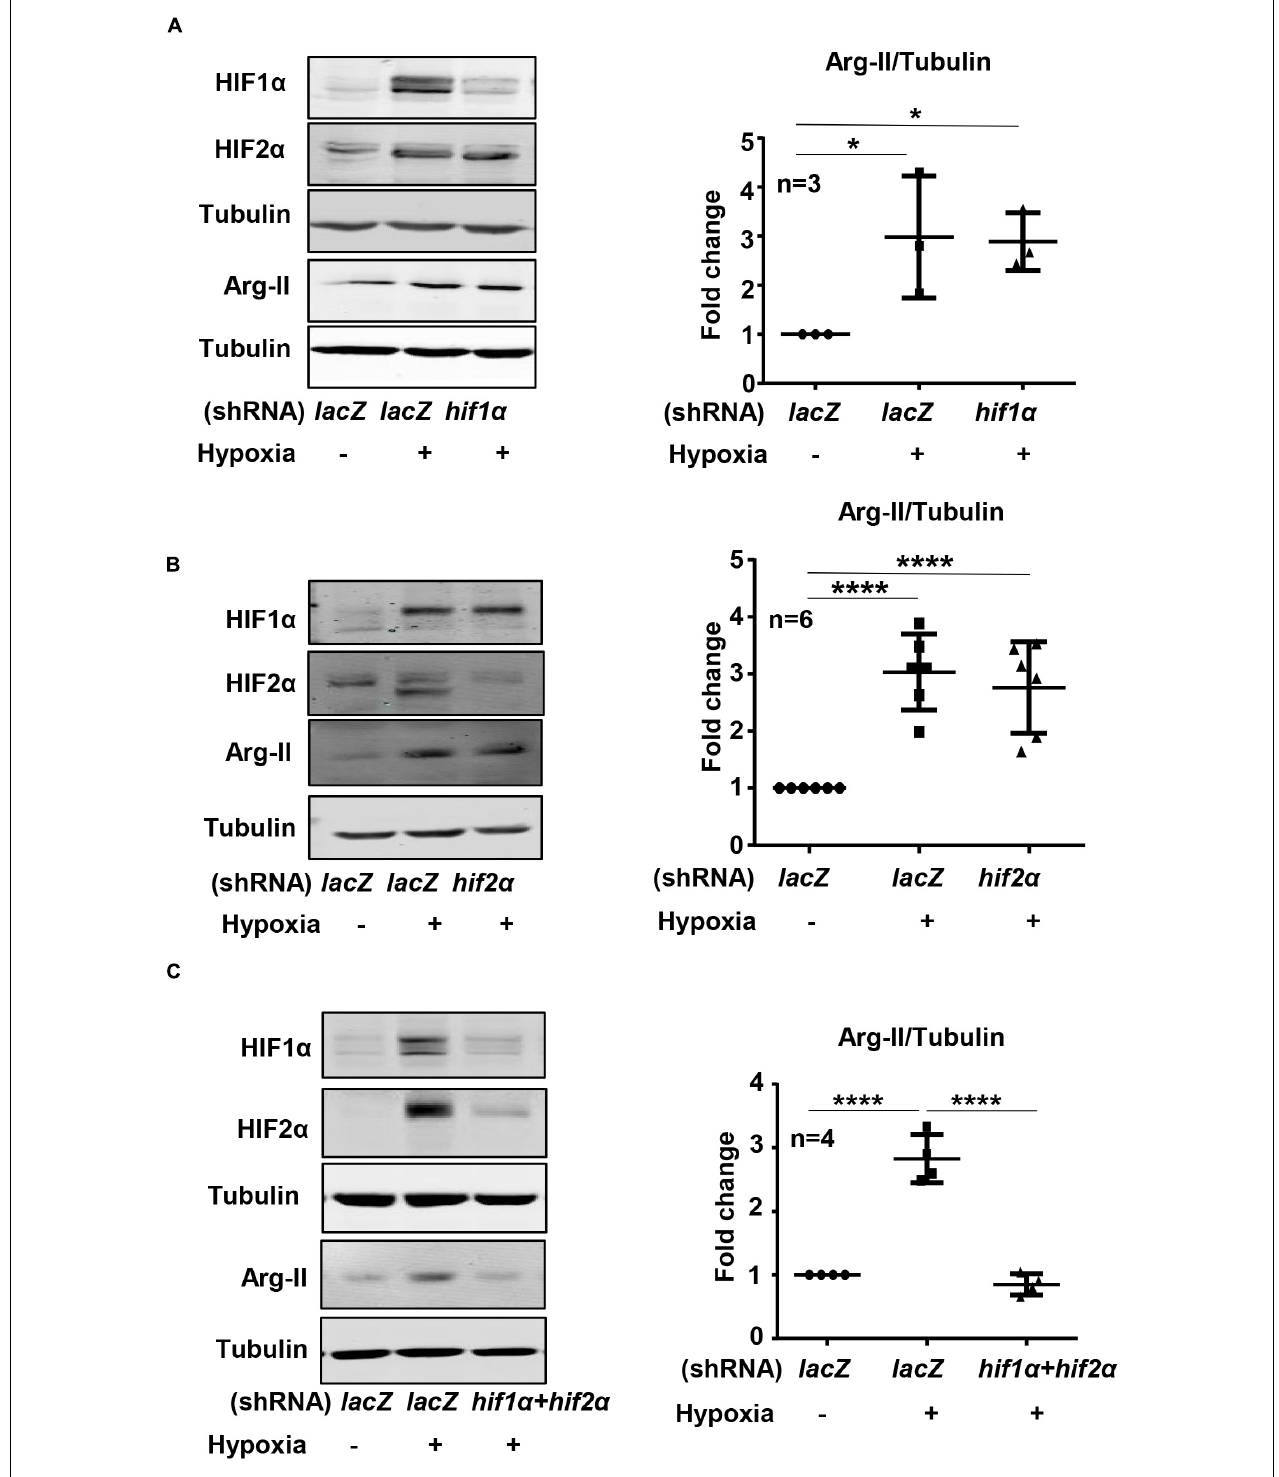
FIGURE 2 | Effects of HIF-silencing on Arg-II expression under hypoxia conditions in HK-2 cells. HK-2 cells were transduced with rAd/U6-LacZ shRNA as control or rAd/U6- hif1 α shRNA and rAd/U6- hif2 α shRNA to silence hif1 α and hif2 α gene, respectively. Immunoblotting analyses illustrating effects of (A) hif1 α silencing, (B) hif2 α silencing, and (C) simultaneous silencing of both hif1 α and hif2 α on Arg-II upregulation in HK-2 cells under hypoxia conditions. The graphs on the right indicate the quantification of the signals on the immunoblots. Data are presented as mean ± SD. * P < 0.05, **** P < 0.0001 between the indicated groups. ANOVA with Bonferroni post hoc test was